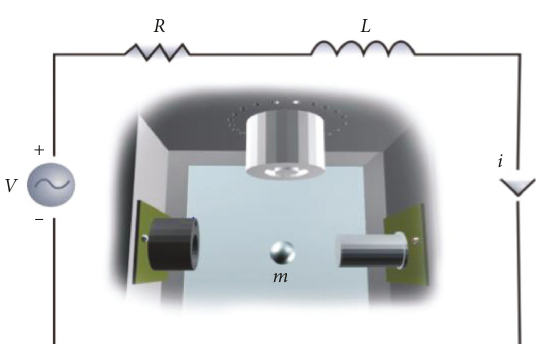
Figure 2: Electrical circuit of the Maglev system: electrical model of the system.